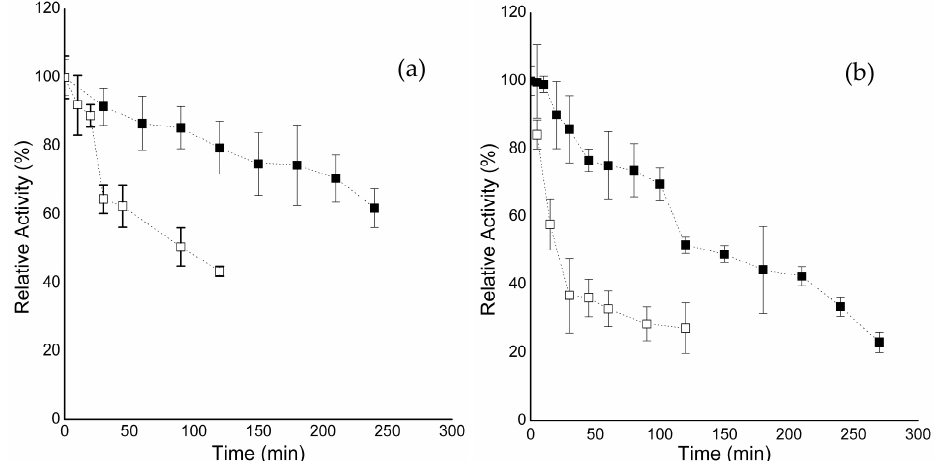
Figure 2. Thermal inactivation at different temperatures in pH 6.0 buffer, at ( a ) 50 ◦ C and ( b ) 60 ◦ C. ( (cid:3) ) Free and ( (cid:4) ) immobilized enzymes. Error bars represent the standard deviation from the mean of three independent experiments.